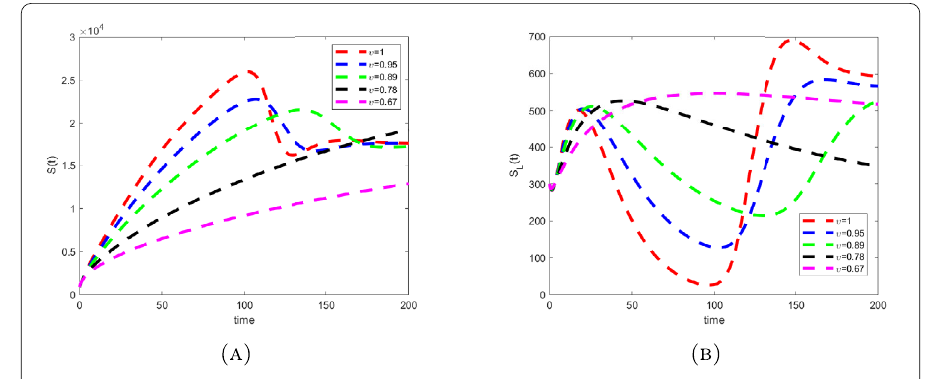
Figure 2 Dynamical outlook of the susceptible class that aren’t under lockdown abd susceptible class that are under lockdown with different fractional-order values